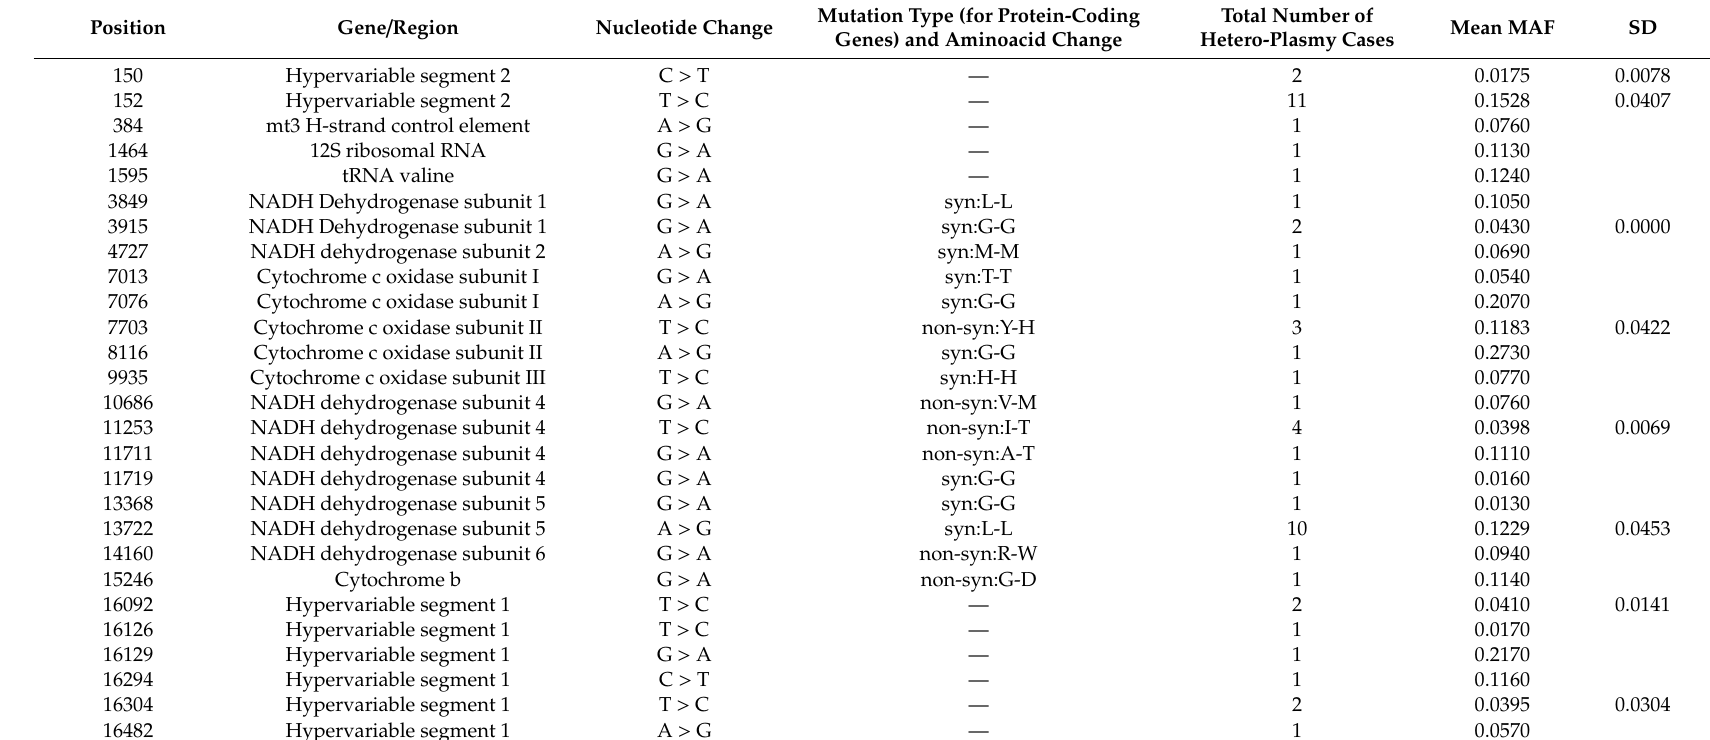
Table 2. Heteroplasmic mtDNA variants found in the aortic intimal